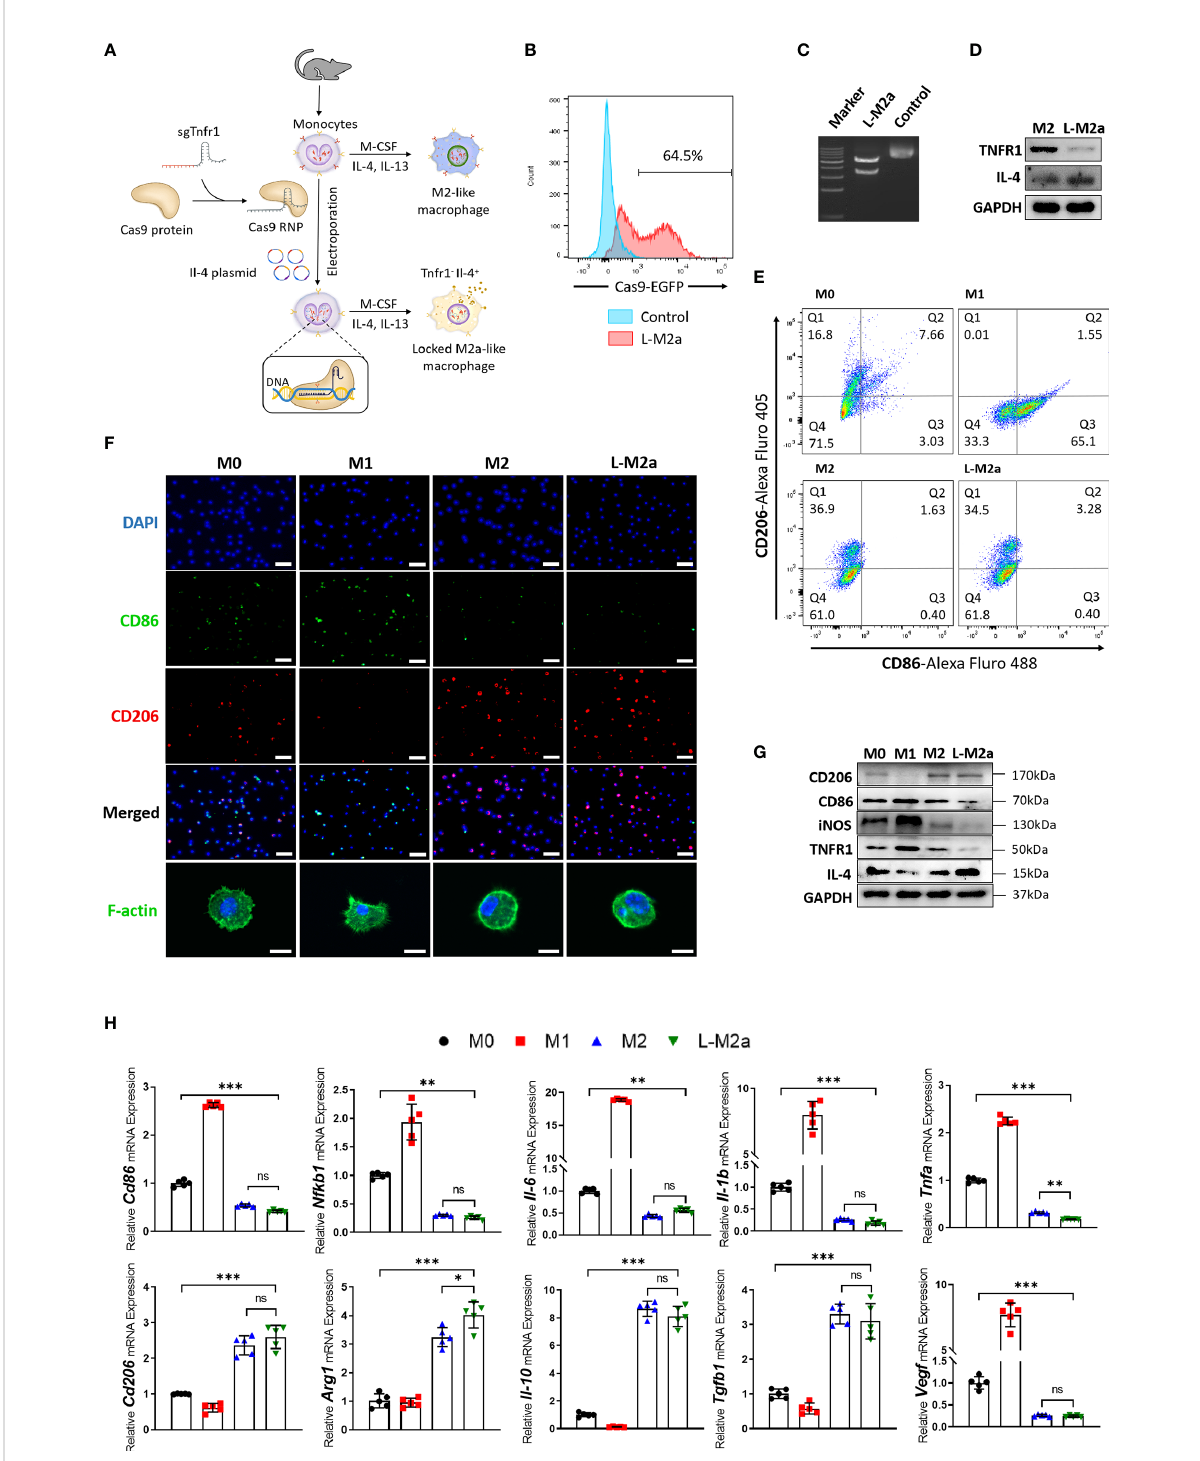
FIGURE 1 Construction and identi fi cation of L-M2a M j . (A) Illustration of the polarization of M0, M1, M2 M j and construction of L-M2a M j . (B-D) Validation of knockout ef fi ciency of sgTNFR1-EGFP-Cas9-RNP and overexpression of pCDNA -IL-4 using fl ow cytometry (B) , DNA cleavage assay (C) and western blot (D) . (E-H) Polarized phenotype, in fl ammatory phenotype and morphological differences among M0, M1, M2a, L-M2a M j by western blot (E, n=3), immuno fl uorescence (F, upper part, bar= 100 m m), confocal (F, bottom part, bar=10 m m), fl ow cytometry (G) and RT-qPCR (H, n=5). ∗ p < 0.05; ∗∗ p < 0.01; ∗∗∗ p < 0.001. ns, no signi fi cance; M j , macrophage; L-M2a M j , locked M2a